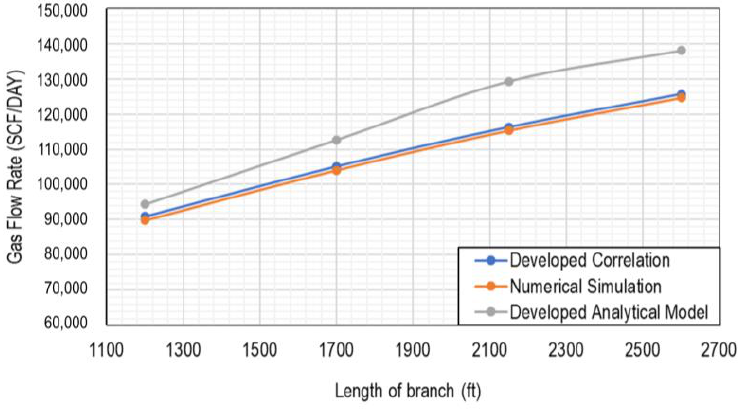
Figure 13. The effect of the length of branches on the cumulative production.